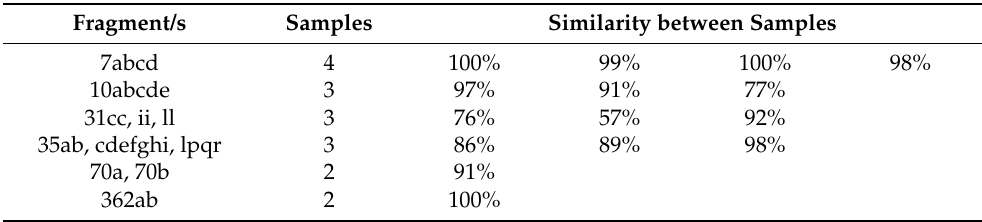
Figure 5. The isotopic results (expressed relative to V ‐ PDB) of all the measured samples plot in ( a ) the isotopic reference envelopes from [63] and ( b ) the 90% confidence ellipses from [65]. In ( c ), some samples have been identified to show the relative dispersion of samples from a given fragment and the outlier (238a). Table 2. Similarity between the isotopic ratios of different samples from a single fragment (or from different matching fragments) and the corresponding computed centroid. For fragments with only two samples, similarity was directly computed with the corresponding Euclidian distance.